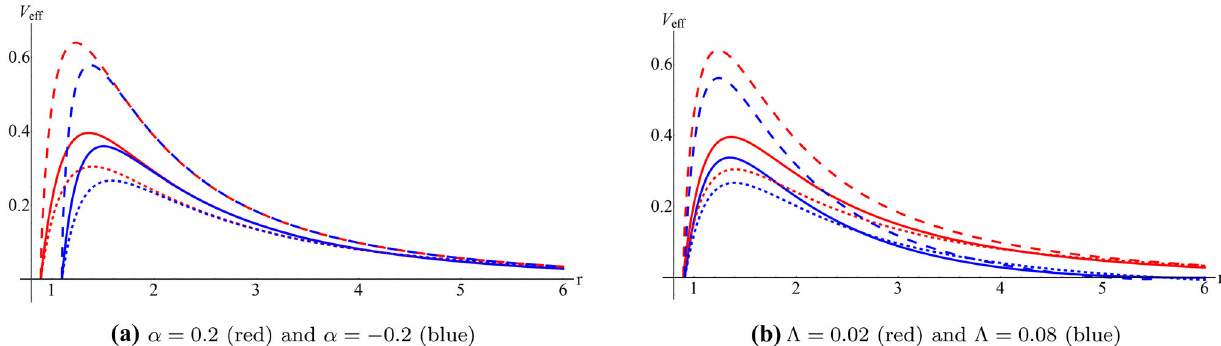
Fig. 1 The figure plots the effective potential V ef f with the radial coordinate r for the scalar(solid), electromagnetic (dotted) and the Dirac (dashed) perturbation